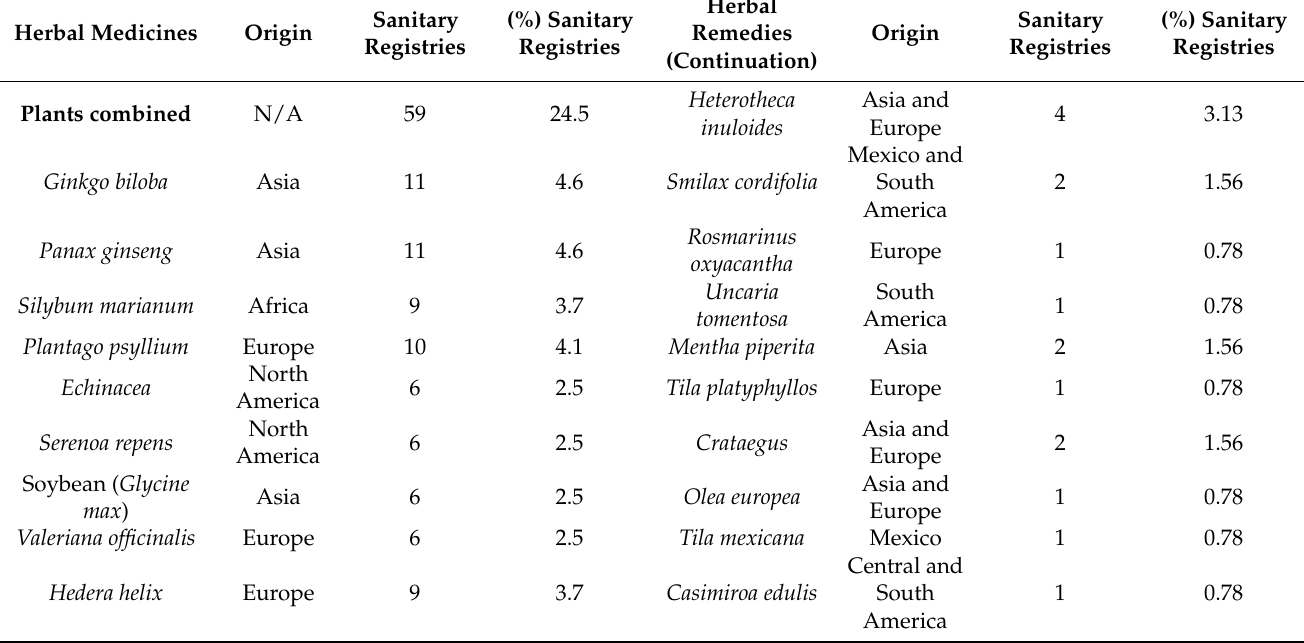
Table 1. Medicinal plants with sanitary registries used in herbal medicines and herbal